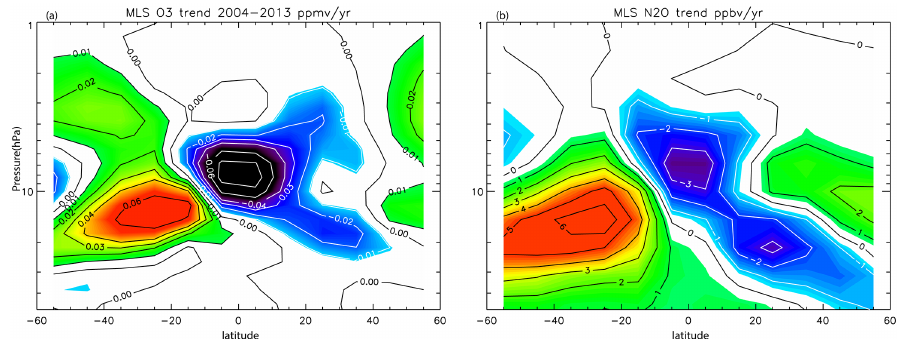
Figure 10. Linear trend fits to MLS O 3 and N 2 O measurements from August 2004 through May 2013. Contour lines for O 3 are shown at ± 0.01, 0.02, 0.03, 0.04, 0.06, 0.08ppmvyr − 1 . Contour lines for N et al.